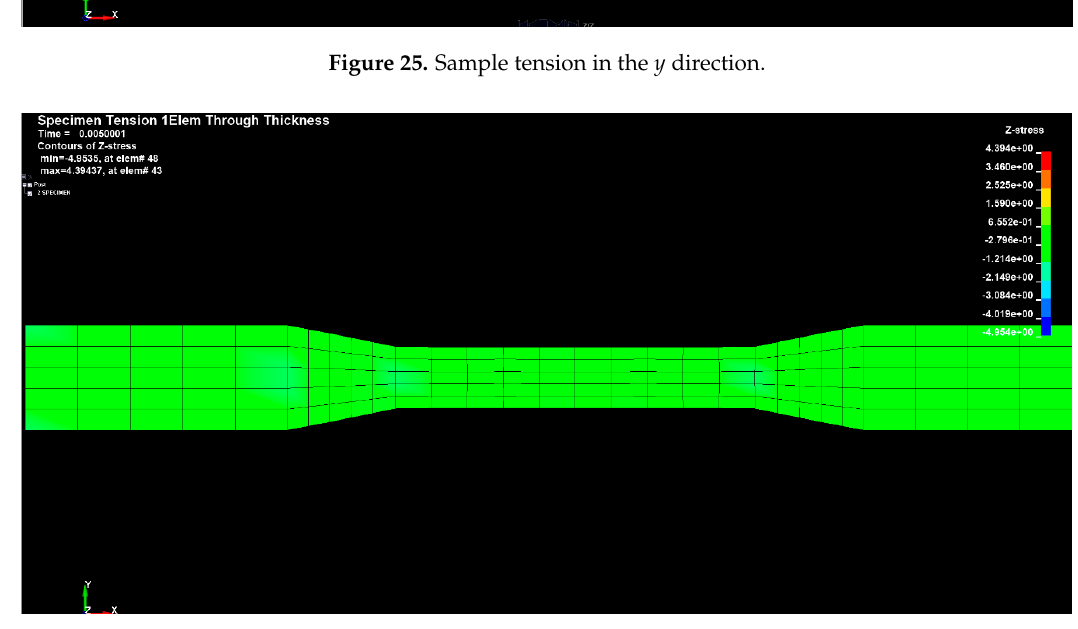
Figure 26. Sample tension in the 𝑧 direction.